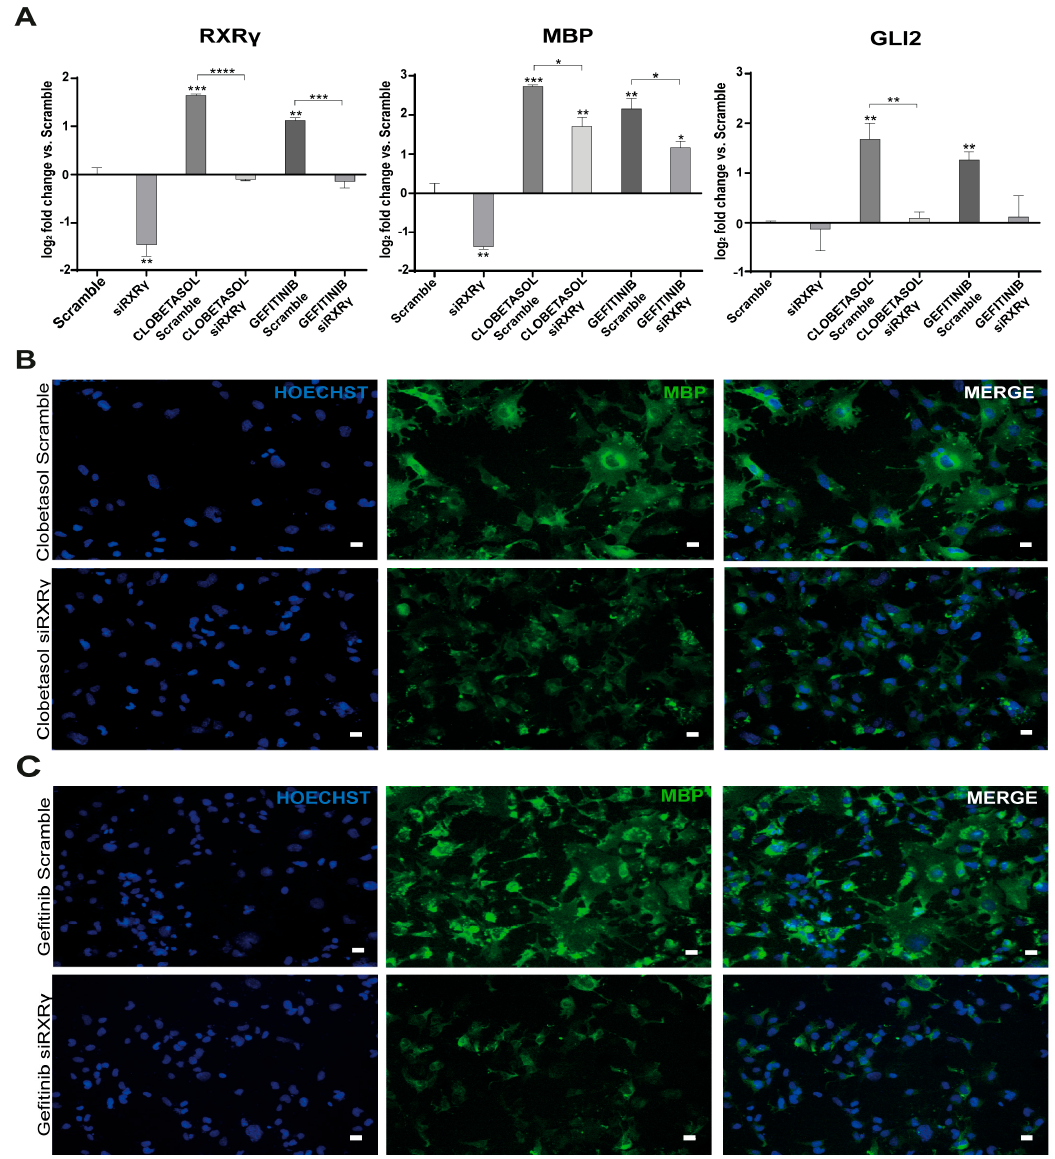
Figure 2. RXR γ gene silencing reduces MBP expression under Clobetasol or Gefitinib treatment. ( A ) qPCR analyses of RXR γ , MBP, and Gli2 gene expression in Scramble-silenced (Scramble) or RXR γ -silenced (siRXR γ ) Oli-neuM cells. Cells were seeded and treated as indicated in Materials and Methods. After 48 h mRNA was extracted and processed for qPCR using oligos indicated in Table S2. Data were normalized to an internal control (GAPDH) and plotted as log 2 fold change vs. control (mean of siScramble 2 + 7) ± SEM (n ≥ 4) using GraphPad Prism. Log 2 fold changes were used to show graphically the positive and negative changes in expression in a symmetrical manner. The level of expression in the control (which equals 1) is represented as 0. Statistical significance: two-tailed paired Student’s t test was used for treatment versus control. One-way ANOVA with post-hoc Tukey was used for comparing multiple treatments. * p < 0.05, ** p < 0.01, *** p < 0.001, **** p < 0.0001. ( B ) Representative images of siScramble-silenced or siRXR γ Oli-neuM cells treated for 48 h with Clobetasol or ( C ) Gefitinib. Immunofluorescence analyses were performed with anti-MBP and nuclei were stained with HOECHST (Blue) as indicated in Materials and Methods. Scale bar: 10 µ